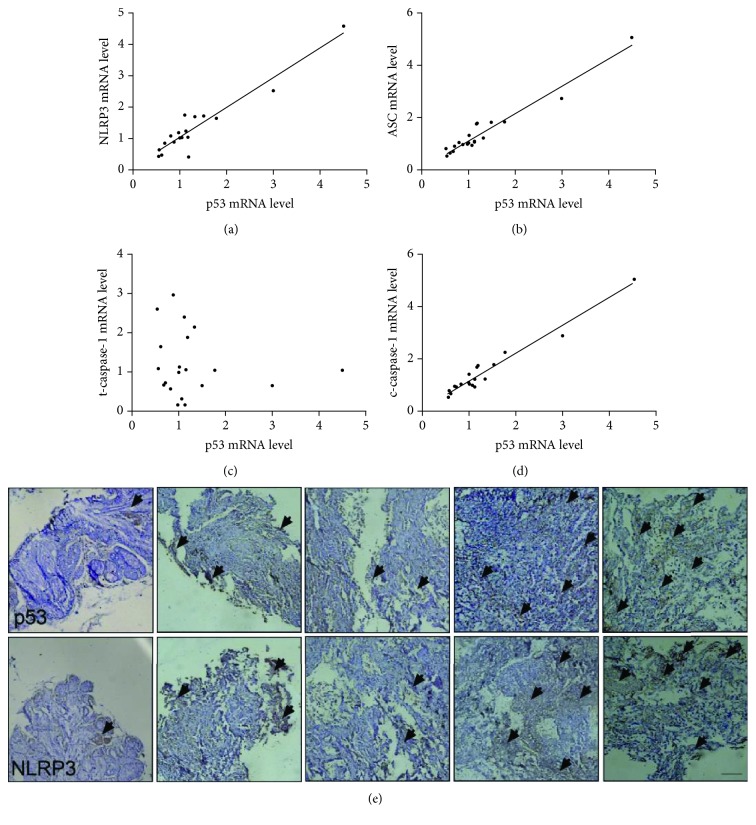
p53 is positively related to pyroptosis in the tumor tissue of NSCLC patients. (a–d) mRNA levels of NLRP3, ASC, caspase-1, and cleaved caspase-1 were detected by real-time PCR and analyzed by SPSS. Wild-type p53 mRNA level shows a positive correlation with NLRP3, ASC, and cleaved caspase-1 in tumor tissues of 20 NSCLC patients. (e) p53 protein level (upper panel) and NLRP3 (lower panel) expression were determined by DAB staining. Arrows represent DAB-positive staining area. Scale bar equals 50 μm.